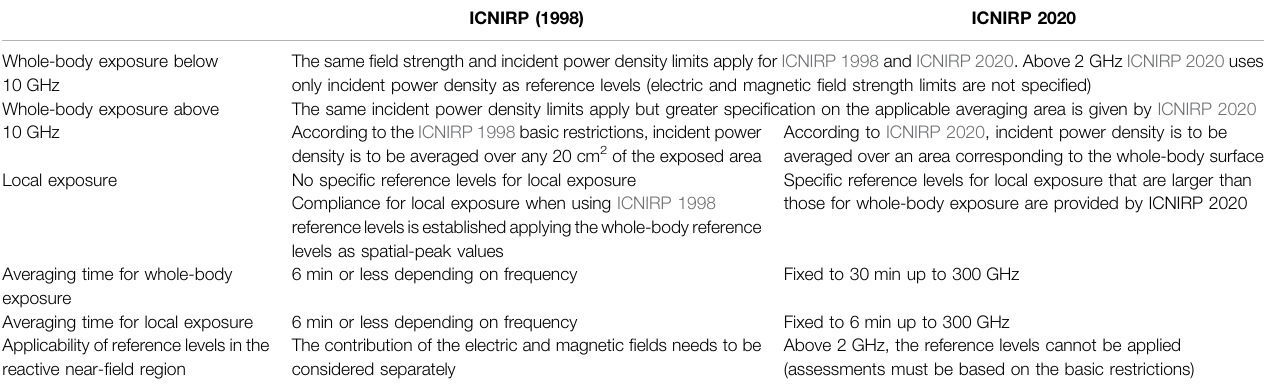
TABLE 1| Comparison ofthereferencelevels applicable tothegeneralpublic asspeci fi edbyICNIRP 2020and ICNRP1998at frequenciesabove 400 MHz. Briefexposure limits applicable for intervals below 6 min are discussed separately in Section 5 . ICNIRP (1998)